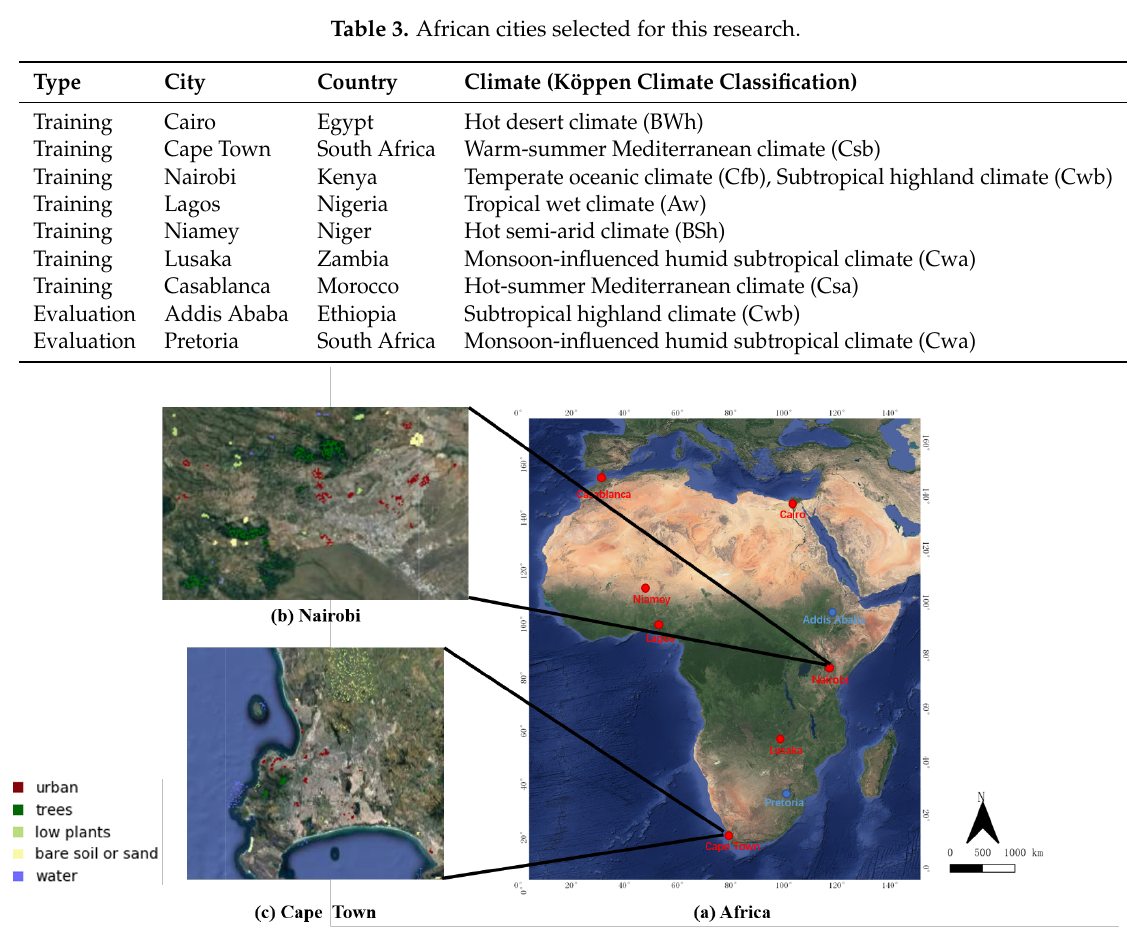
Figure 2. ( a ) Study areas: red circles represents training cities, blue circles represents evaluation cities and the distribution of reference samples from ( b ) Nairobi, and ( c ) Cape